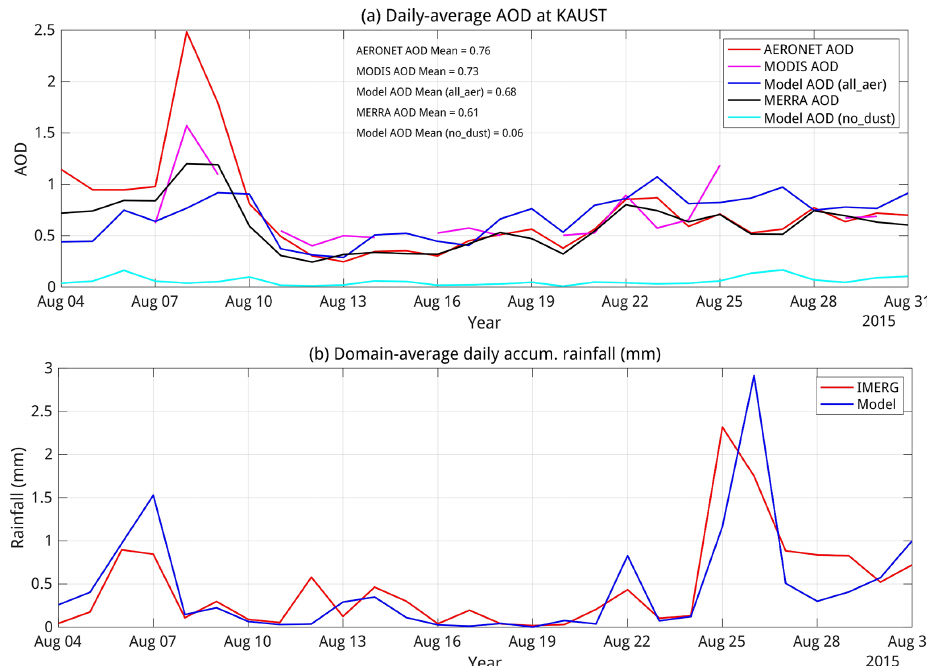
Figure 2. (a) Simulated daily-mean total AOD compared to MODIS and MERRA-2 data at KAUST and (b) simulated daily-accumulated rainfall (mm) compared to IMERG data, averaged over the study domain